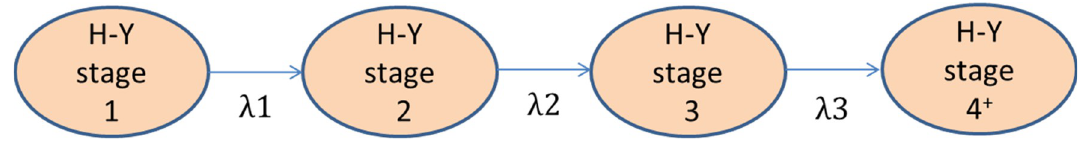
Fig 2. Model for estimating H-Y stage transition